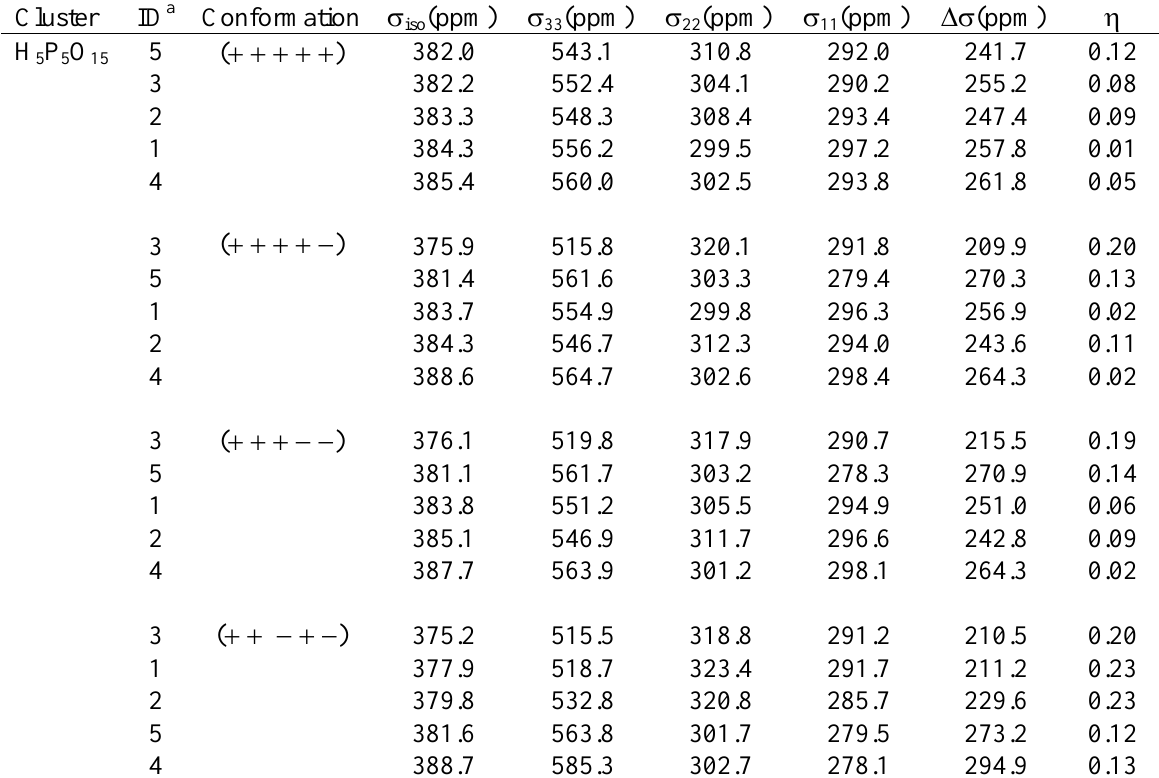
Table 3. Ab Initio NMR CSA Tensors for Cyclic 5-P Membered Phosphate Clusters.